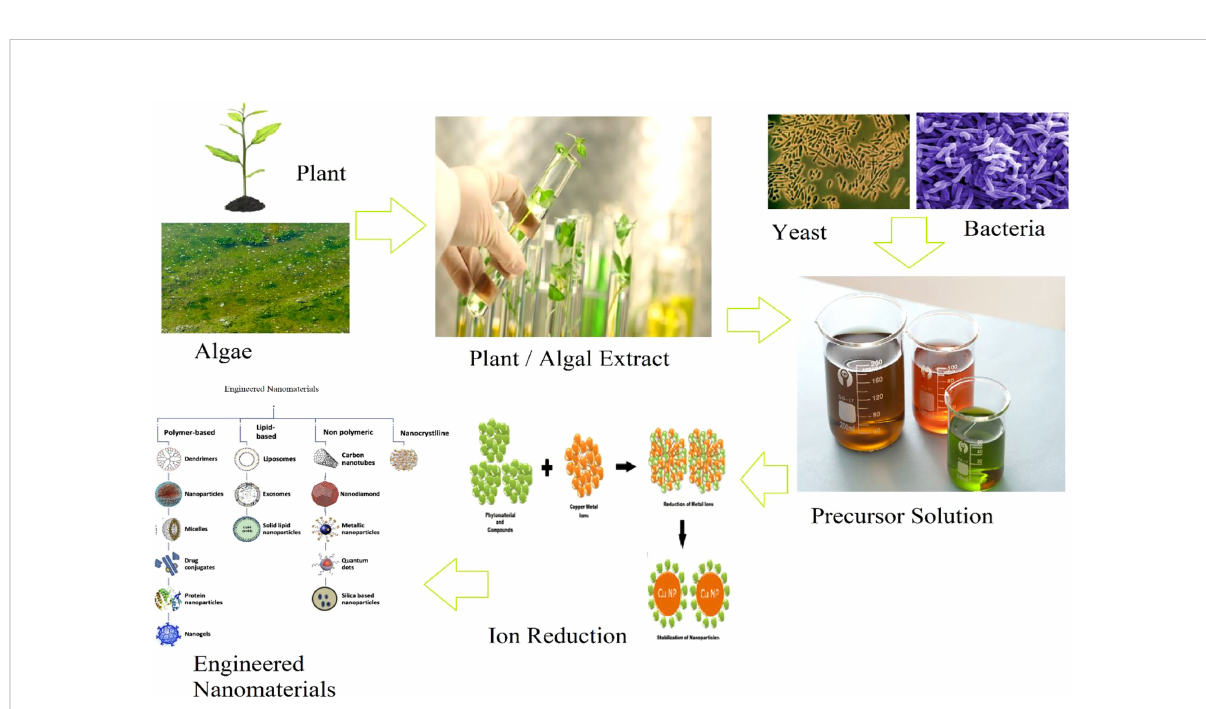
FIGURE 2 Green synthesis scheme of engineered nano materials from various